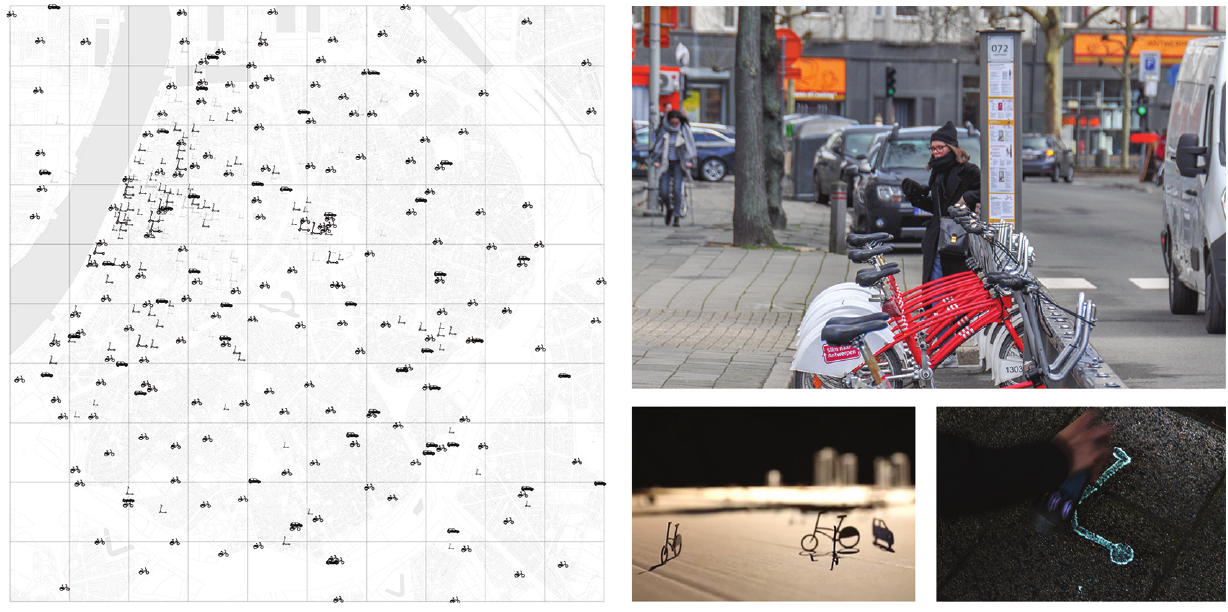
Figure 4. Shared mobility patterns. Left: Map—Traces of different shared mobility features, e-scooters, bikes, and cars in the city of Antwerp. Above right: Picture of City-bike station. Right below from left: Depiction of mobility in the ‘Analogue City’ map; street painting marking the data point of the map. Source: The ‘Analogue City,’ IDW University of Antwerp 2019 students, and the